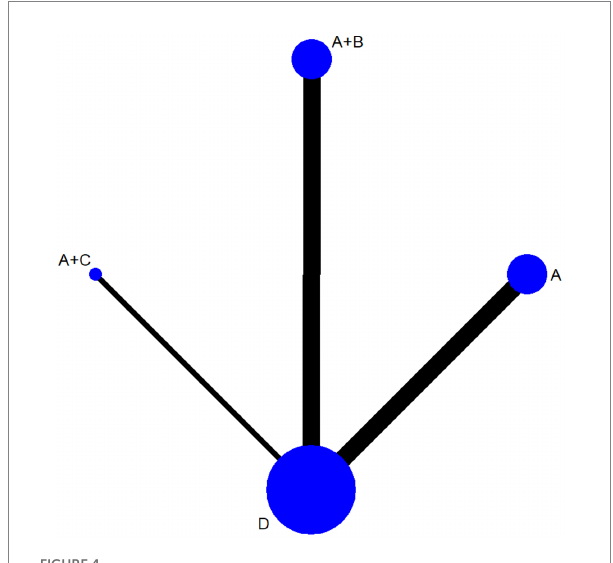
FIGURE 4 Results of pairwise meta-analyses. Acupuncture (A) , acupuncture + traditional Chinese medicine (B) , acupuncture + tuina (C) , western medicine (D) .